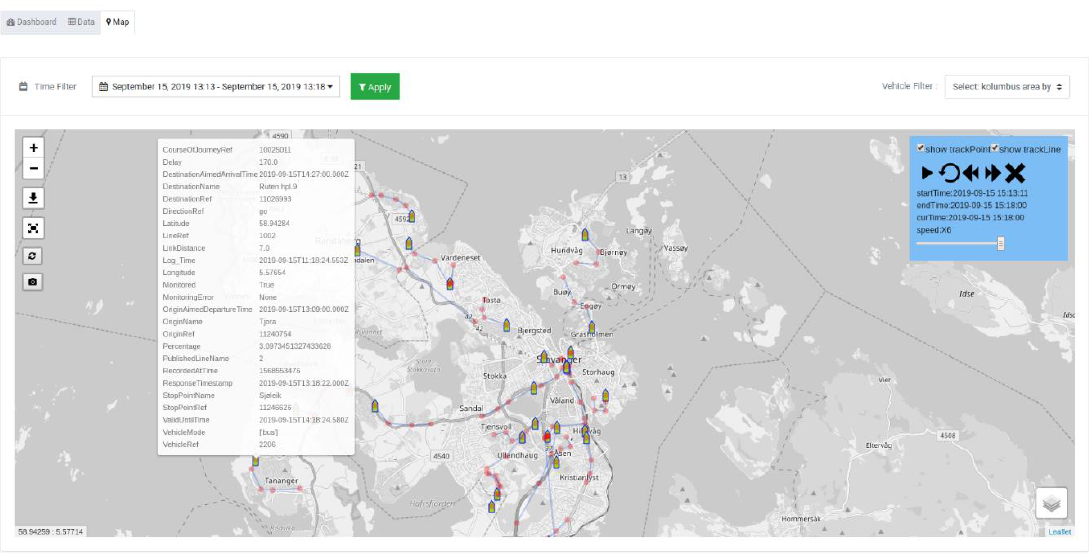
Figure 7. All busses traveling in the area.